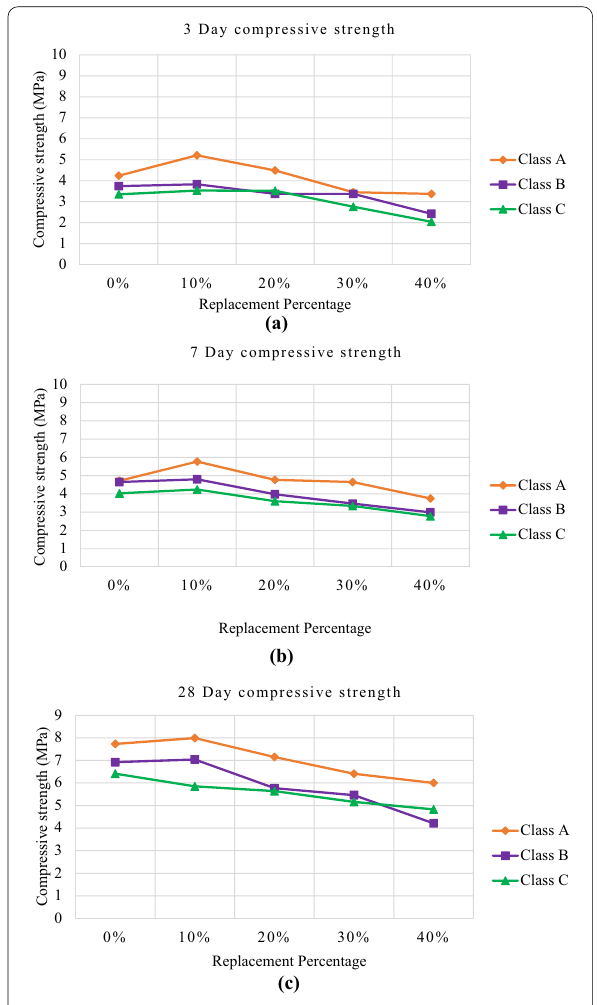
Fig. 4 Effect of cement replacement by crusher dust on compressive strength of HCB.